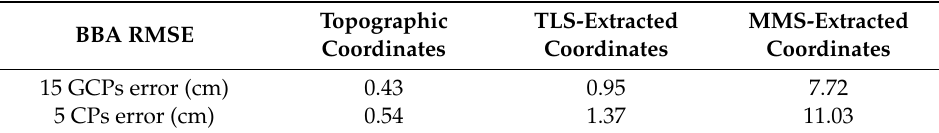
Table 9. Results of the photogrammetric block adjustment using differently accurate set points: the topographic reference measurements on target points, the Ground Control Points (GCPs) extracted from the LiDAR point surface and the ones from the ZEB point